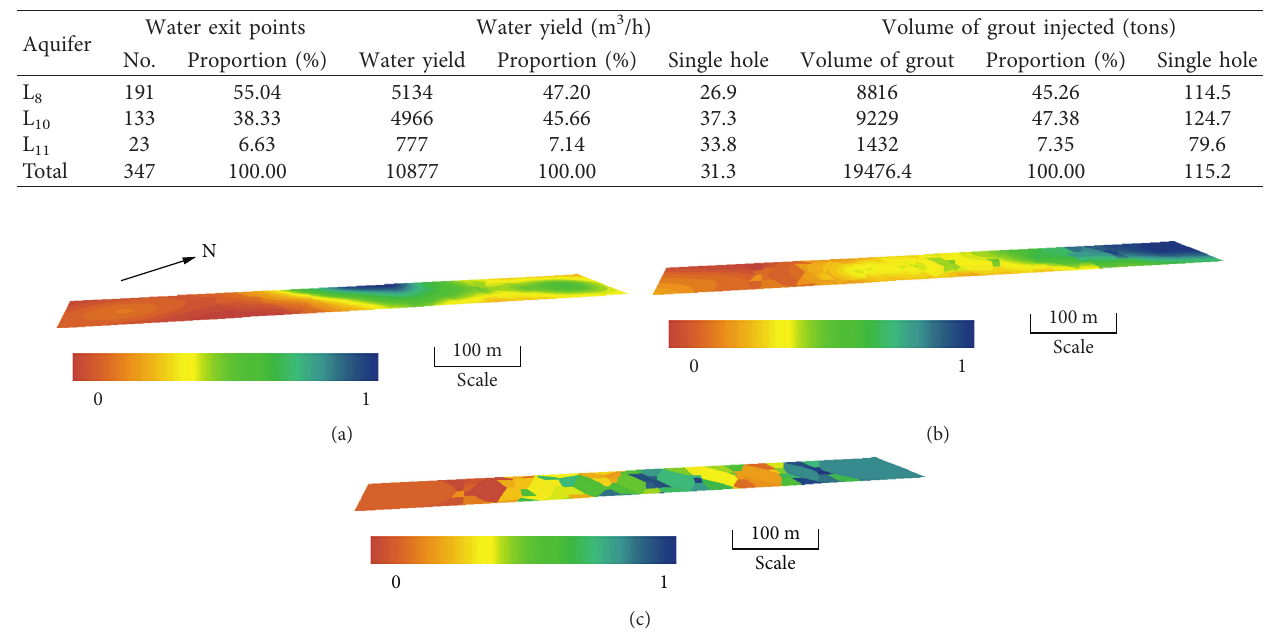
Figure 2: Spatial distribution characteristics of water yield: (a) water yield of L